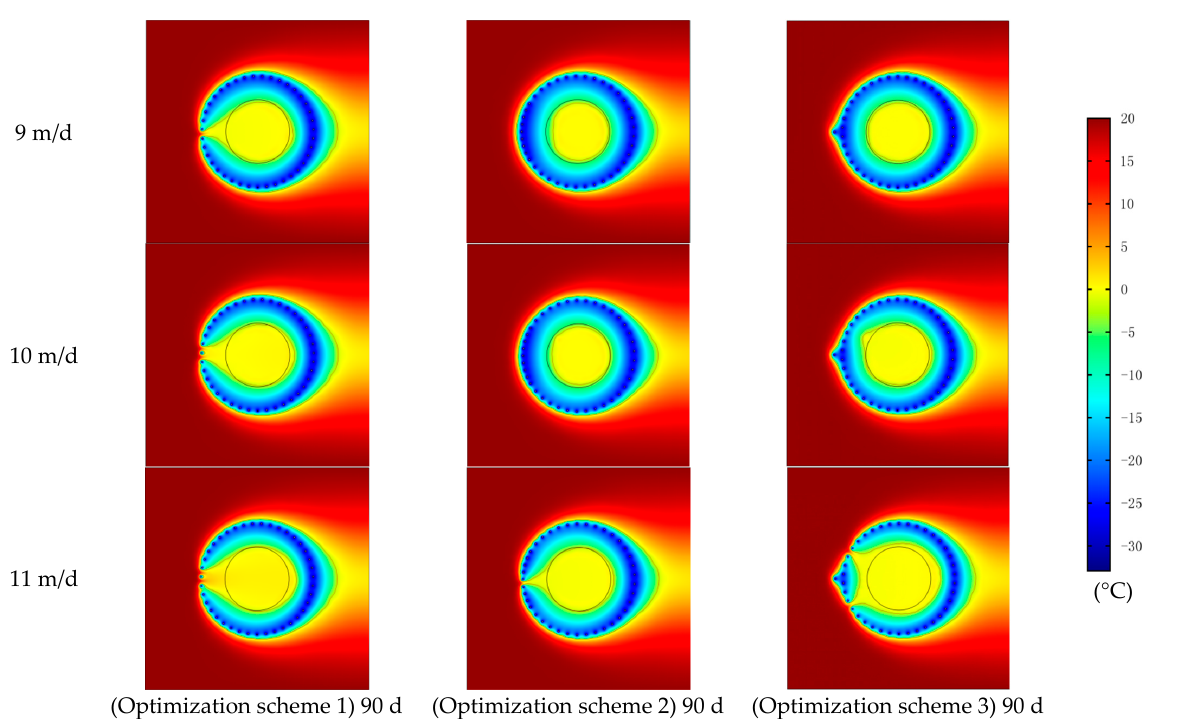
Figure 11. Development law of the freezing temperature field of the single-circle holes after opti-mization.